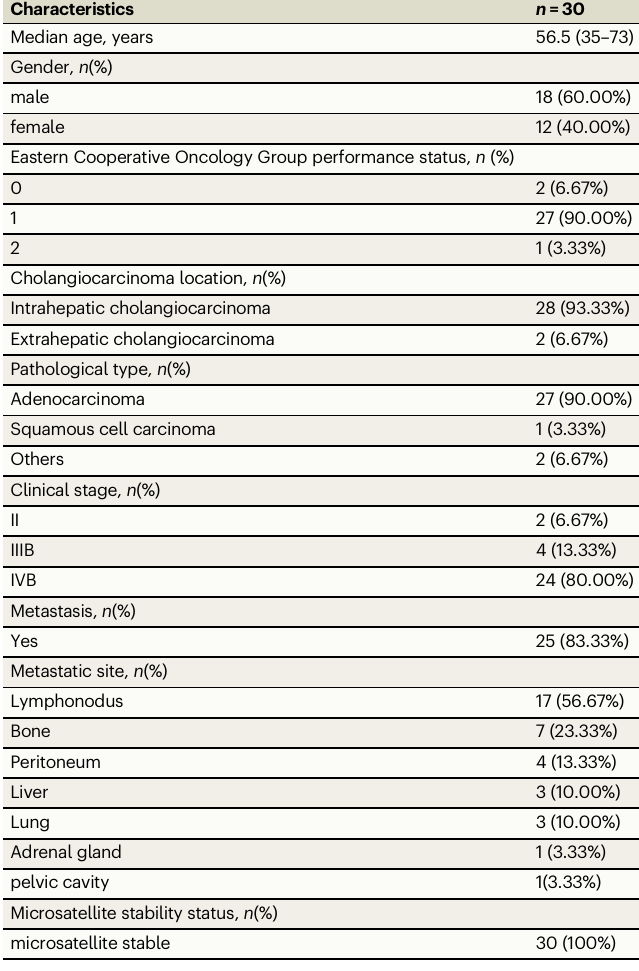
Table 1 | Patient demographics and baseline characteristics